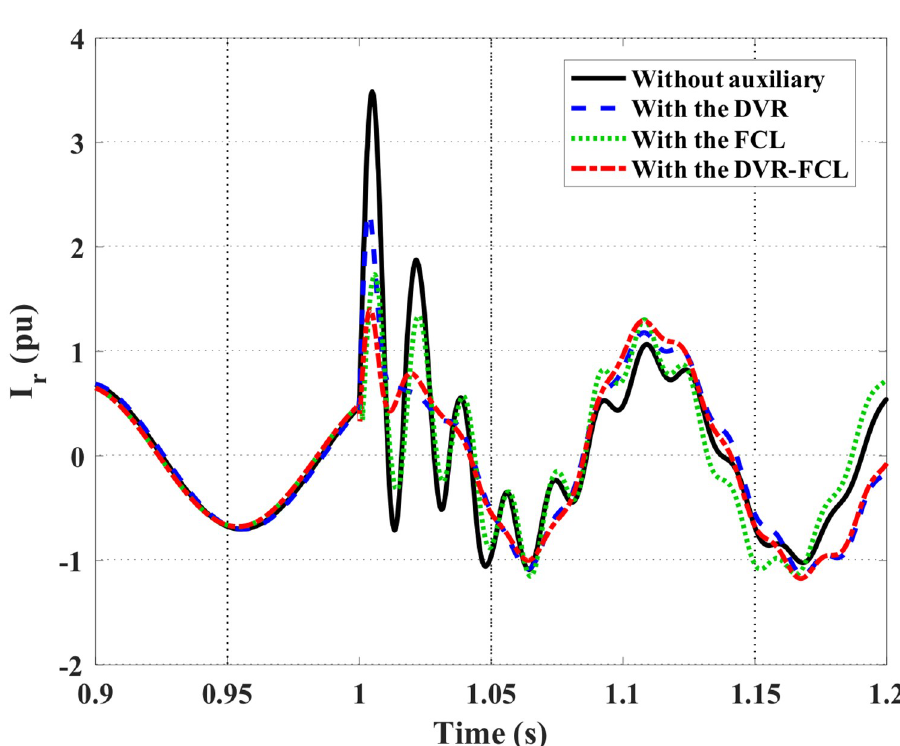
Fig 8. Rotor current of the DFIG subject to the symmetrical